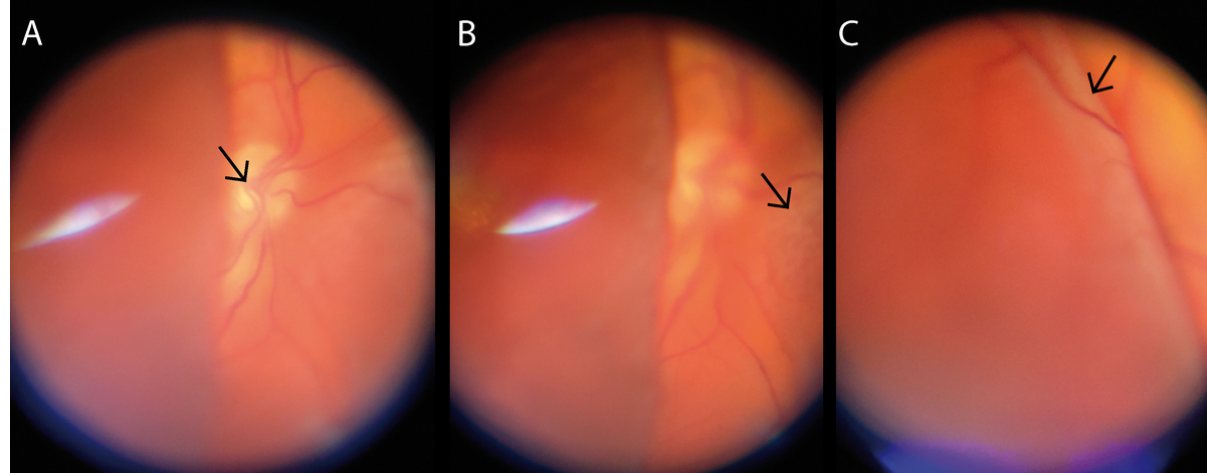
Figure 5. Documentation of different focal planes with smartphone-based fundus imaging in a total retinal detachment. With varying focus, different focal planes (indicated by black arrows) from (A) the optic disc to (B) nasally detached retina to (C) temporal bulla of detached retina can be documented. Note the characteristic reflex artifact in (A) and (B) which can predominantly be seen in pseudophakic